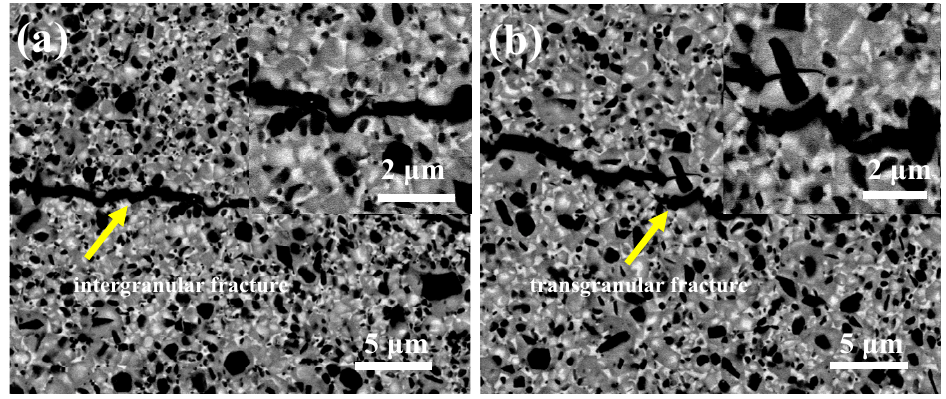
Figure 2. SEM micrographs of crack with Ti(C,N)-based cermets prepared by direct liquid phase sinter-HIP ( a ), and solid phase reaction and liquid phase sinter-HIP ( b ). The wear properties and compositions of abrasive dust of Ti(C,N)-based cermets with the different sintering processes are shown in Figure 3. Figure 3a shows that the extra solid phase reaction can contribute to the reduction of the depth value of the wear track and wear volume in the process of abrasion. It can be seen from Figures 3b,c that the W element contents of the abrasive dust are